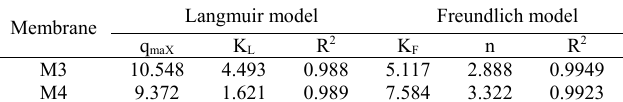
Fig. 4. Applications of adsorption isotherm models for M3 and M4 membranes with the different initial concentrations at pH = 7.0, m = 1 g/L, reaction time = 48 h, (a) Langmuir adsorption isotherm, (b) Freundlich adsorption isotherm Table 3. Langmuir and Freundlich isotherm constants for adsorption . Table 3. Langmuir and Freundlich isotherm constants for